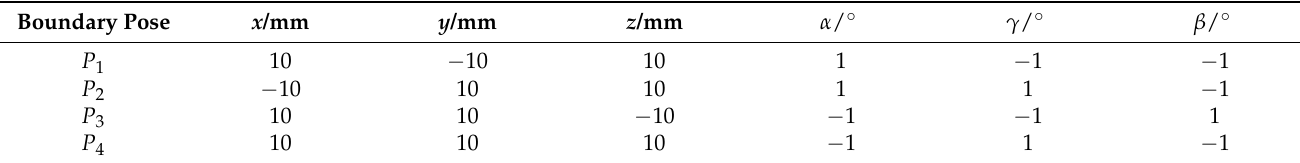
Table 5. Four types of typical boundary pose errors.